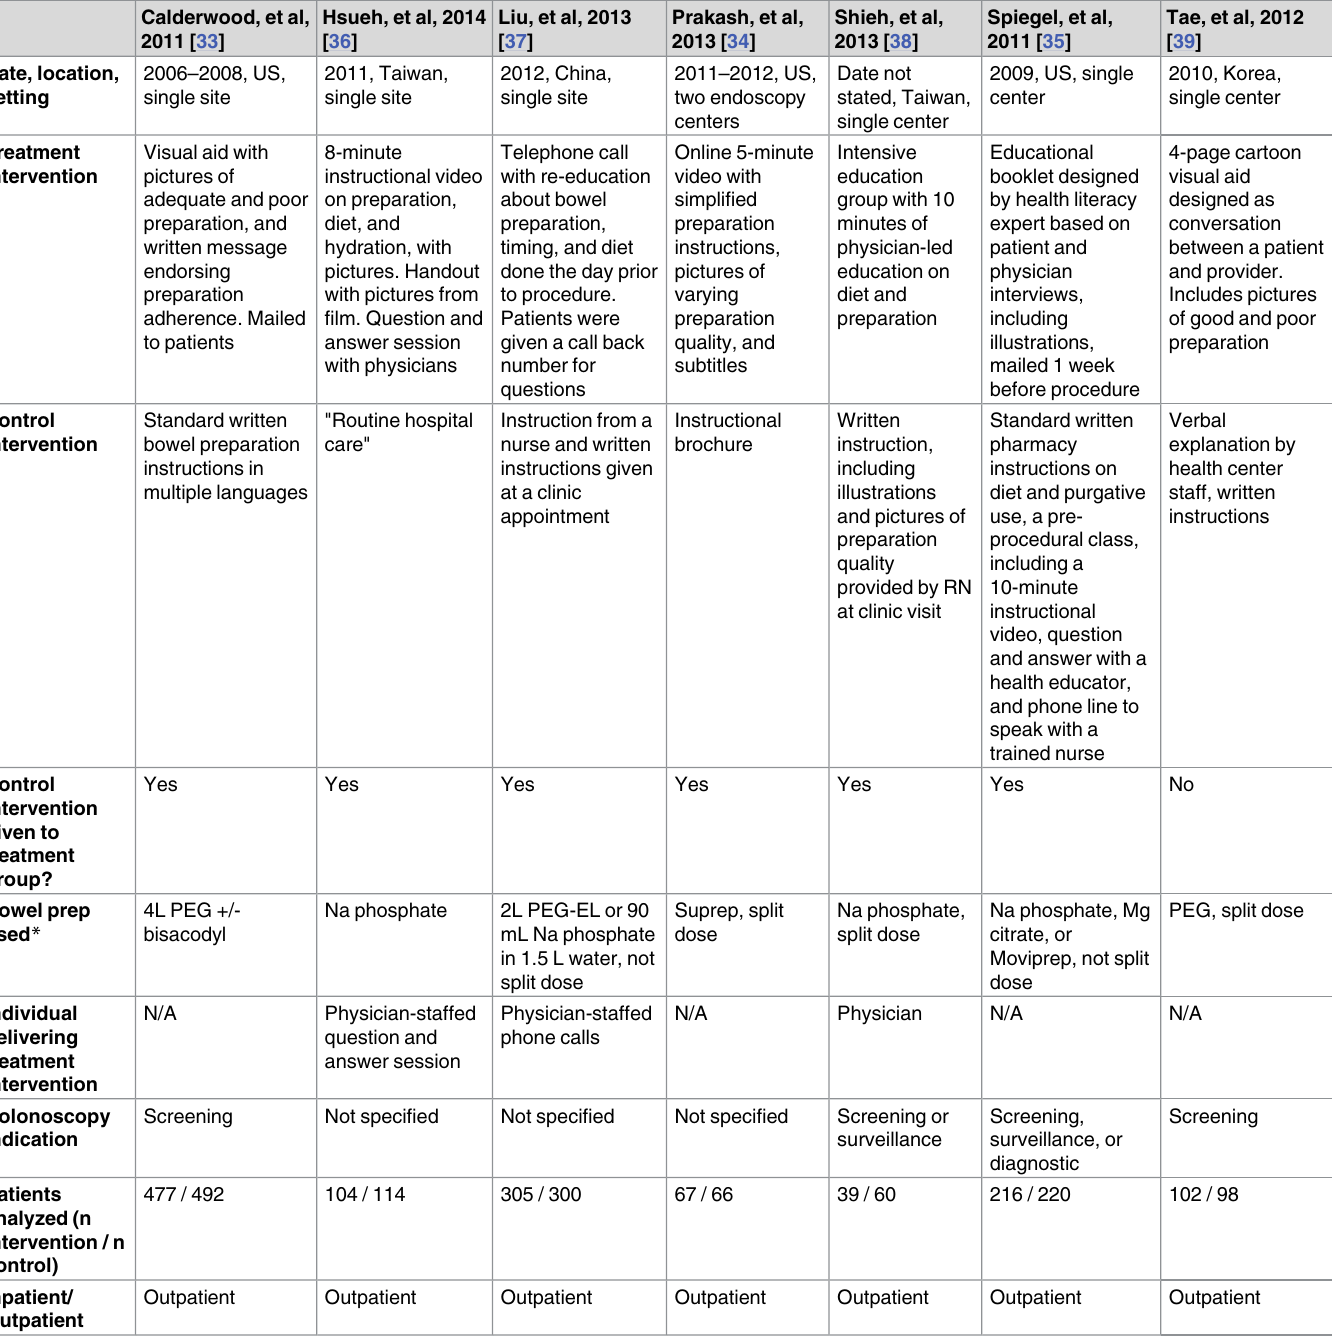
Table 1. Descriptions of full-text studies included in